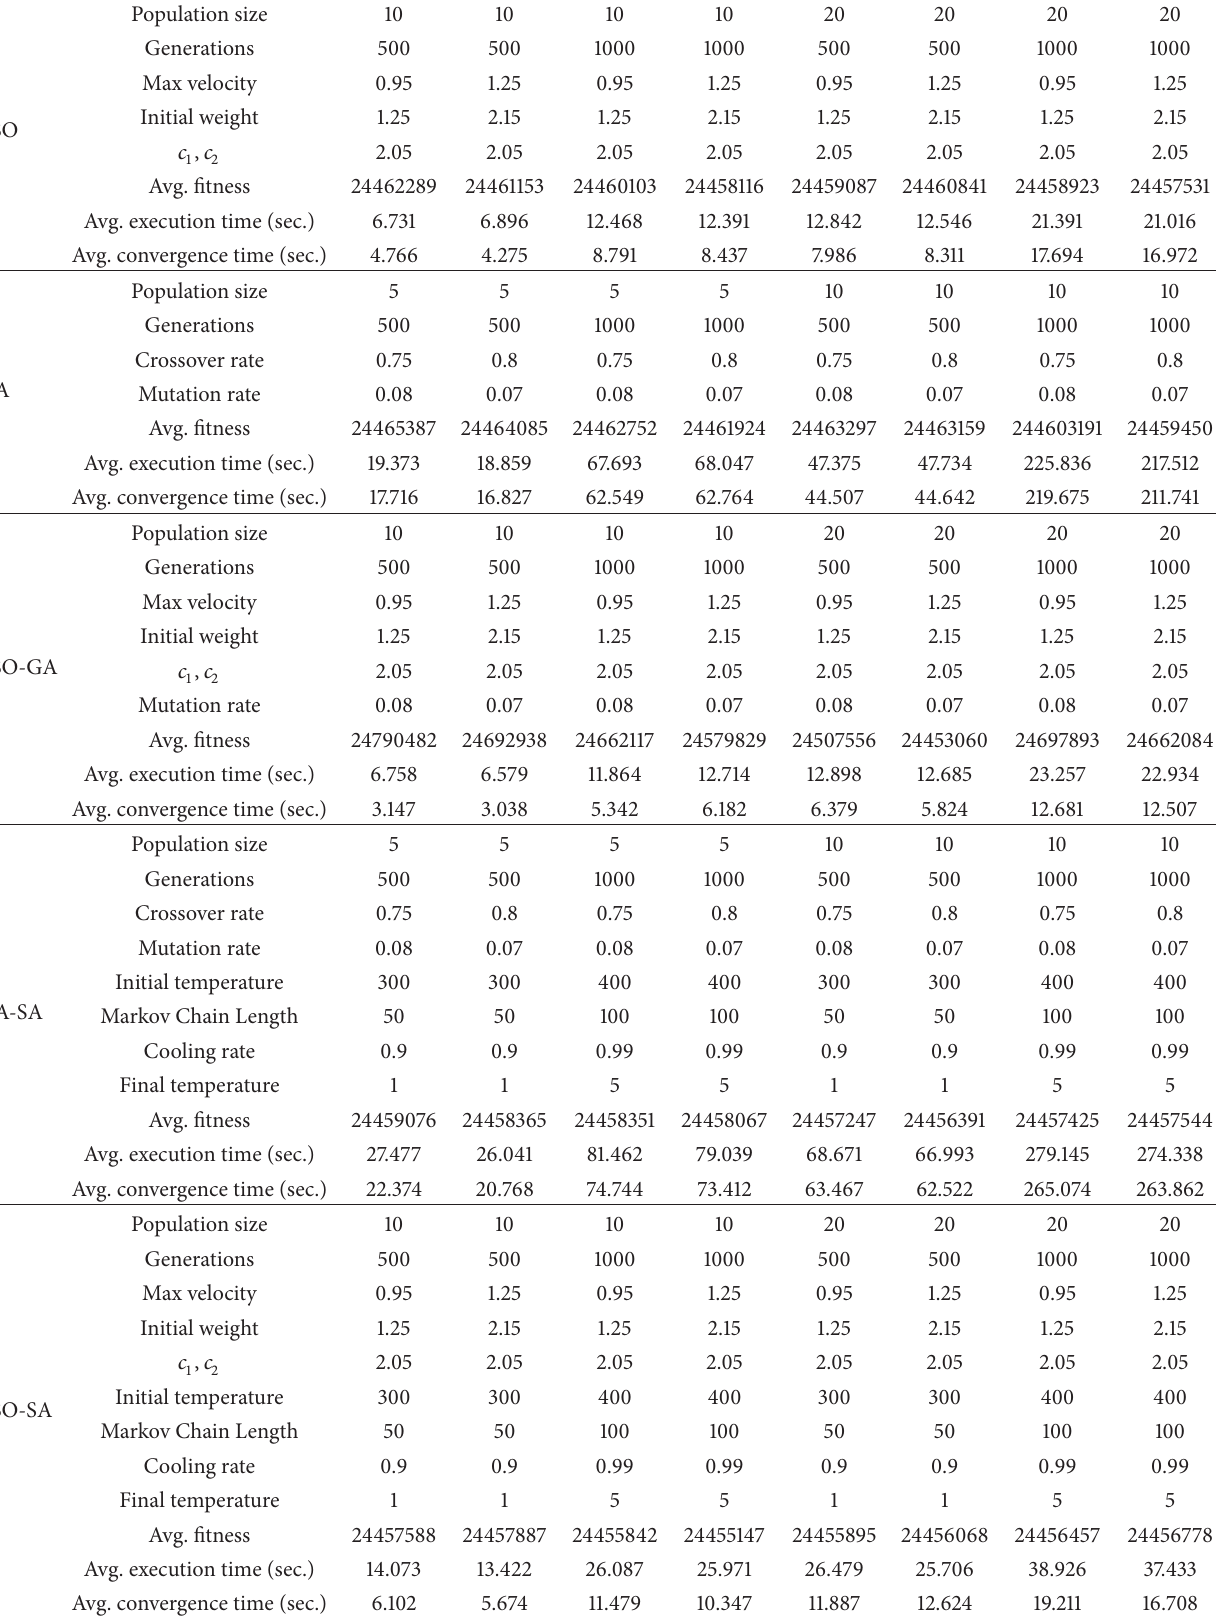
Table 1: Combination of experimental